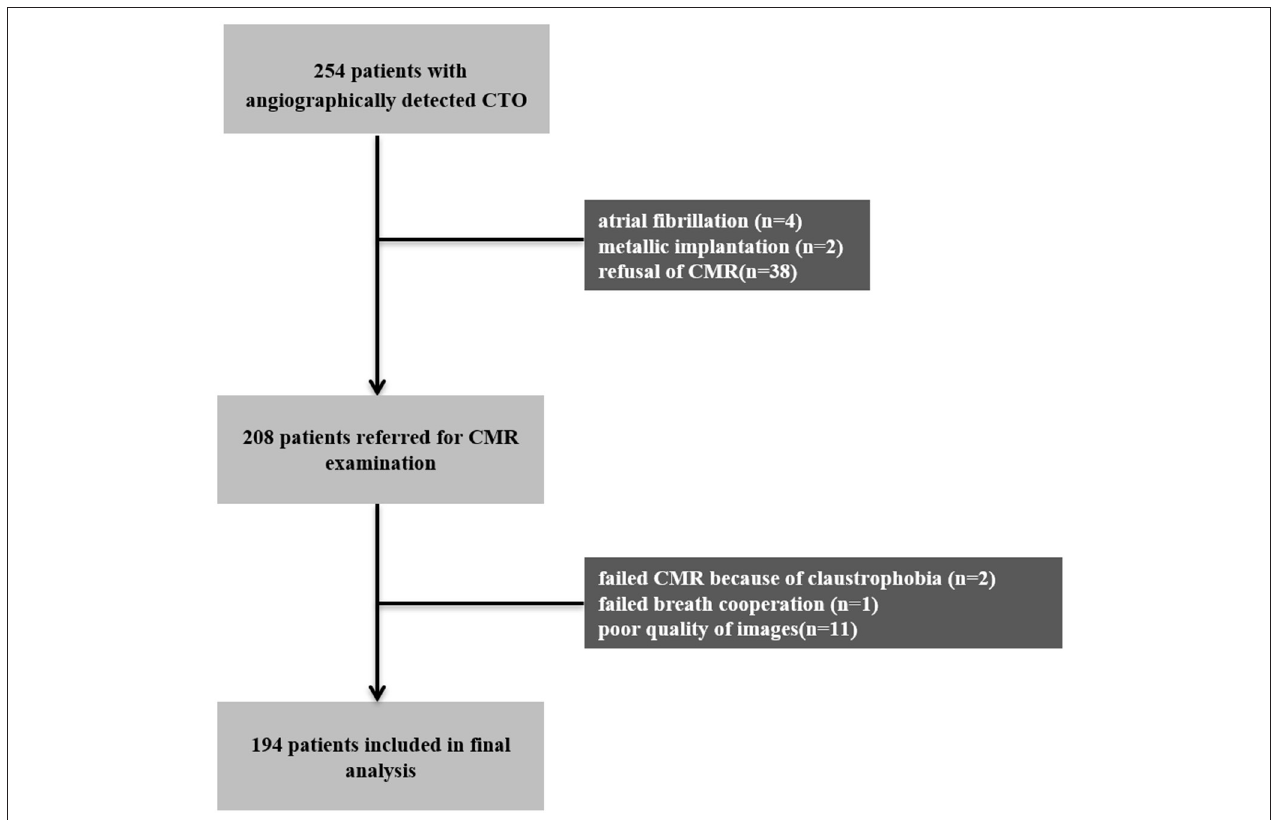
FIGURE 1 | Patient and imaging flowchart. CMR, cardiovascular magnetic resonance; CTO, chronic total